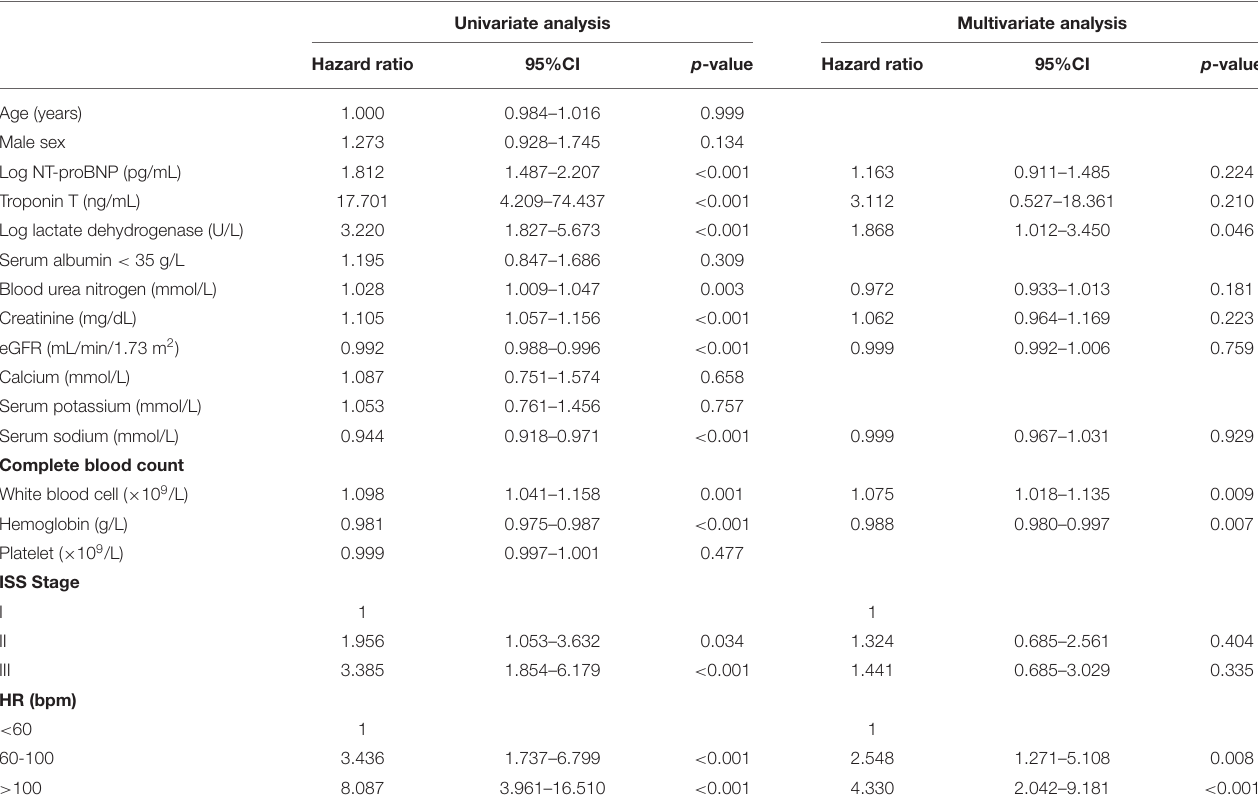
TABLE 2 | Univariate and multivariate analyses for overall mortality. Univariate analysis Multivariate